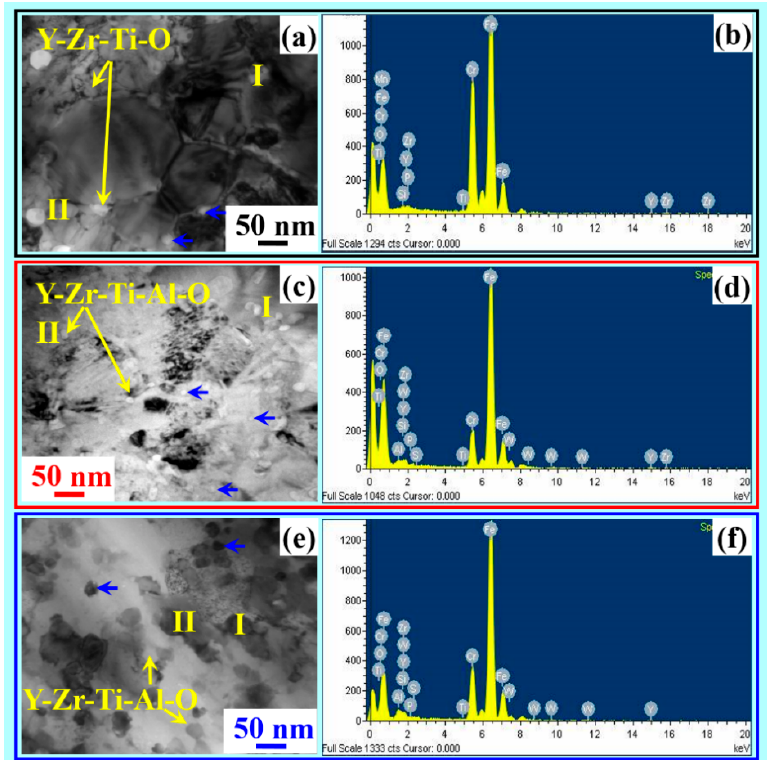
Figure 6. Transmission electron microscopy images and subsequent energy dispersive X-ray